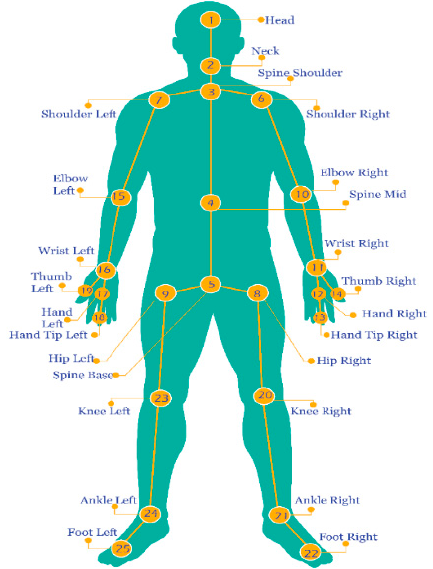
Figure 2. Different skeleton joints of the human body are extracted through sensors.